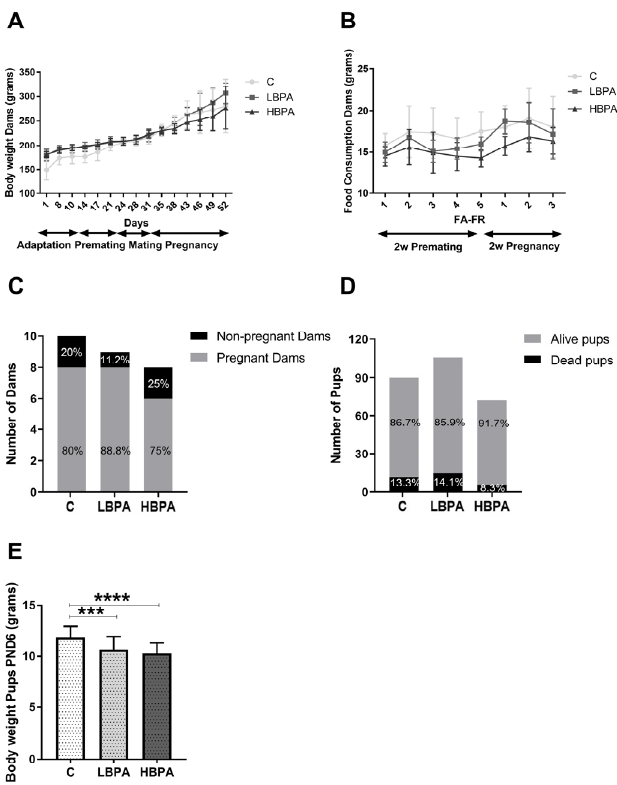
Figure 1. Body weight, food consumption and reproduction data in pregnant dams and neonatal offspring. ( A ) Body weight of dams monitored every 3–4 days; ( B ) food consumption during the second week of premating and the second week of pregnancy; ( C ) number of pregnant and non- pregnant dams; ( D ) percentage of alive and dead offspring after birth and ( E ) body weight of PND6 offspring after birth. Data are represented as mean ± SD. Statistical significance was determined by one-way ANOVA. *** p < 0.001, **** p < 0.0001.